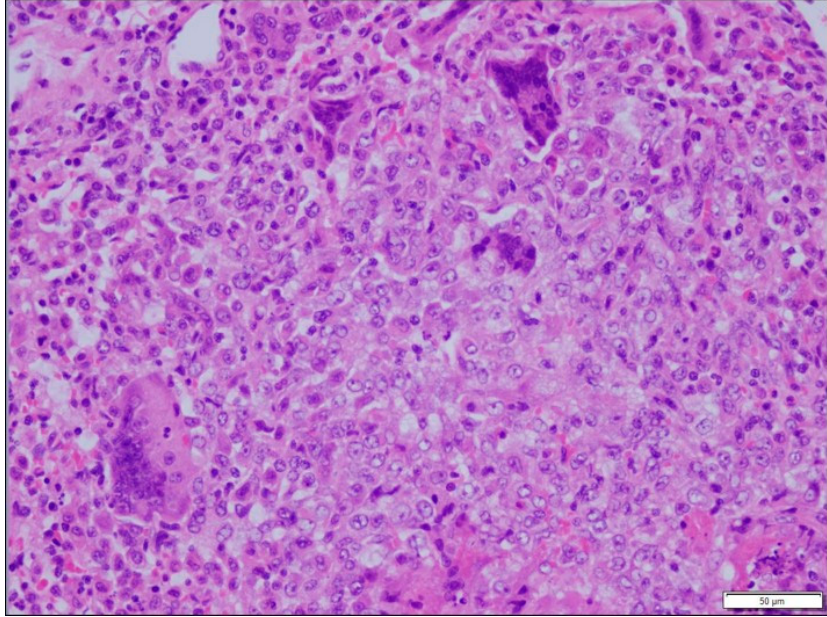
Figure 3. Mongoose 69. Lung. Granuloma with giant cells. No nematodes were visible.